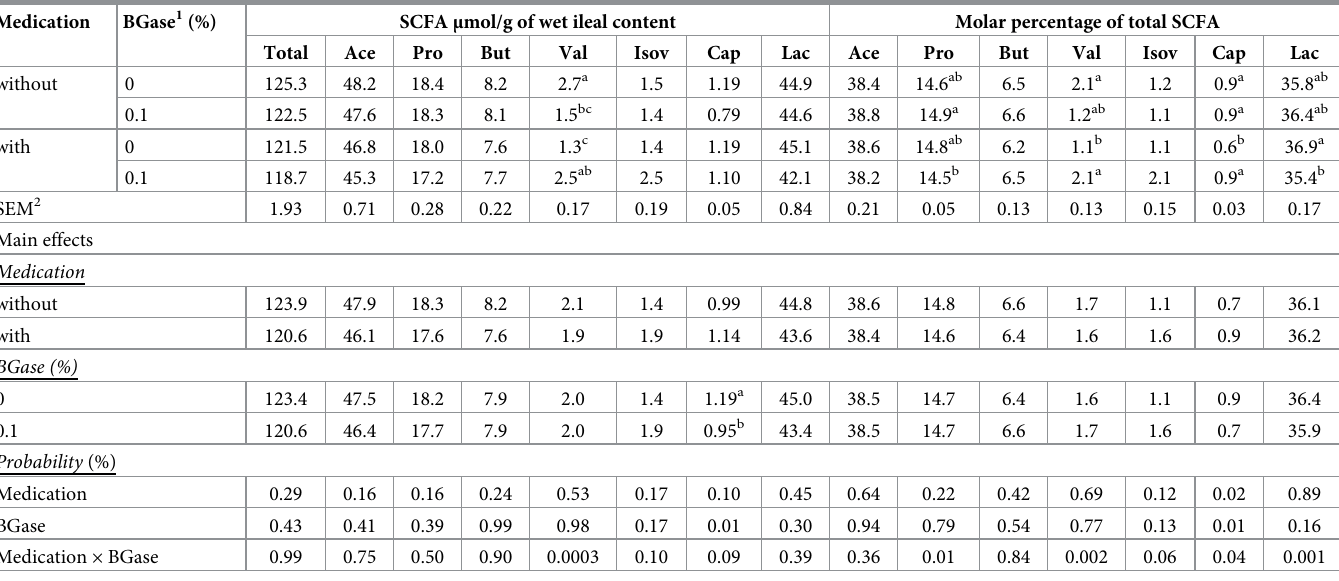
Table 10. Effects of diet medication and β -glucanase on ileal short chain fatty acids of broiler chickens aged 11 days (Experiment 2). Medication